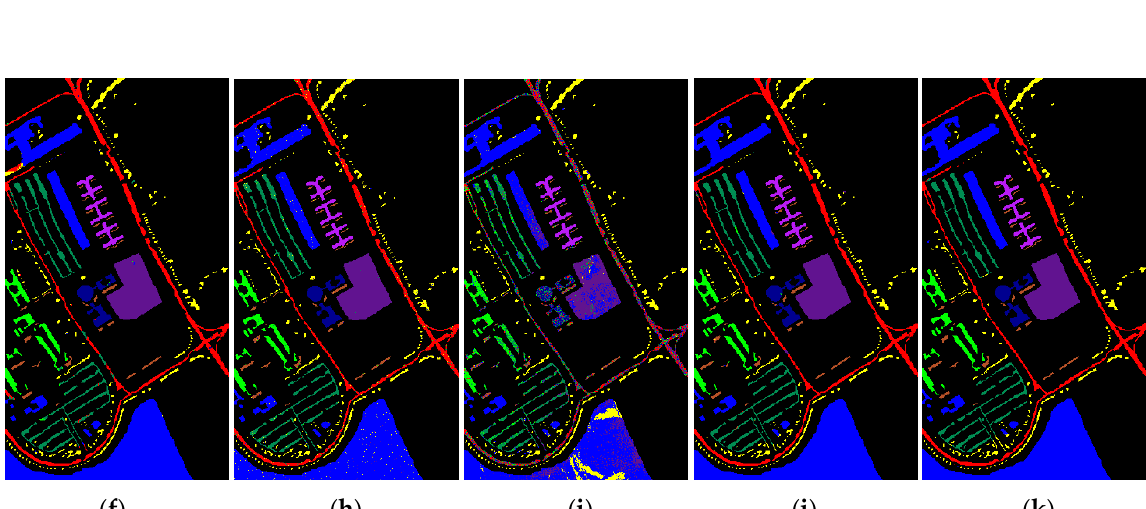
Figure 12. Classification maps of the Salinas dataset. ( a ) SVM 91.89%; ( b ) HiFi-We 91.10%; ( c ) SSG 81.46%; ( d ) EPF 95.92%; ( e ) GSVM 96.93%; ( f ) IFRF 98.86%; ( h ) LPP_LBP_BLS 99.83%; ( i ) BLS 92.00%; ( j ) GBLS 99.84%; ( k ) SSBLS 99.59%.